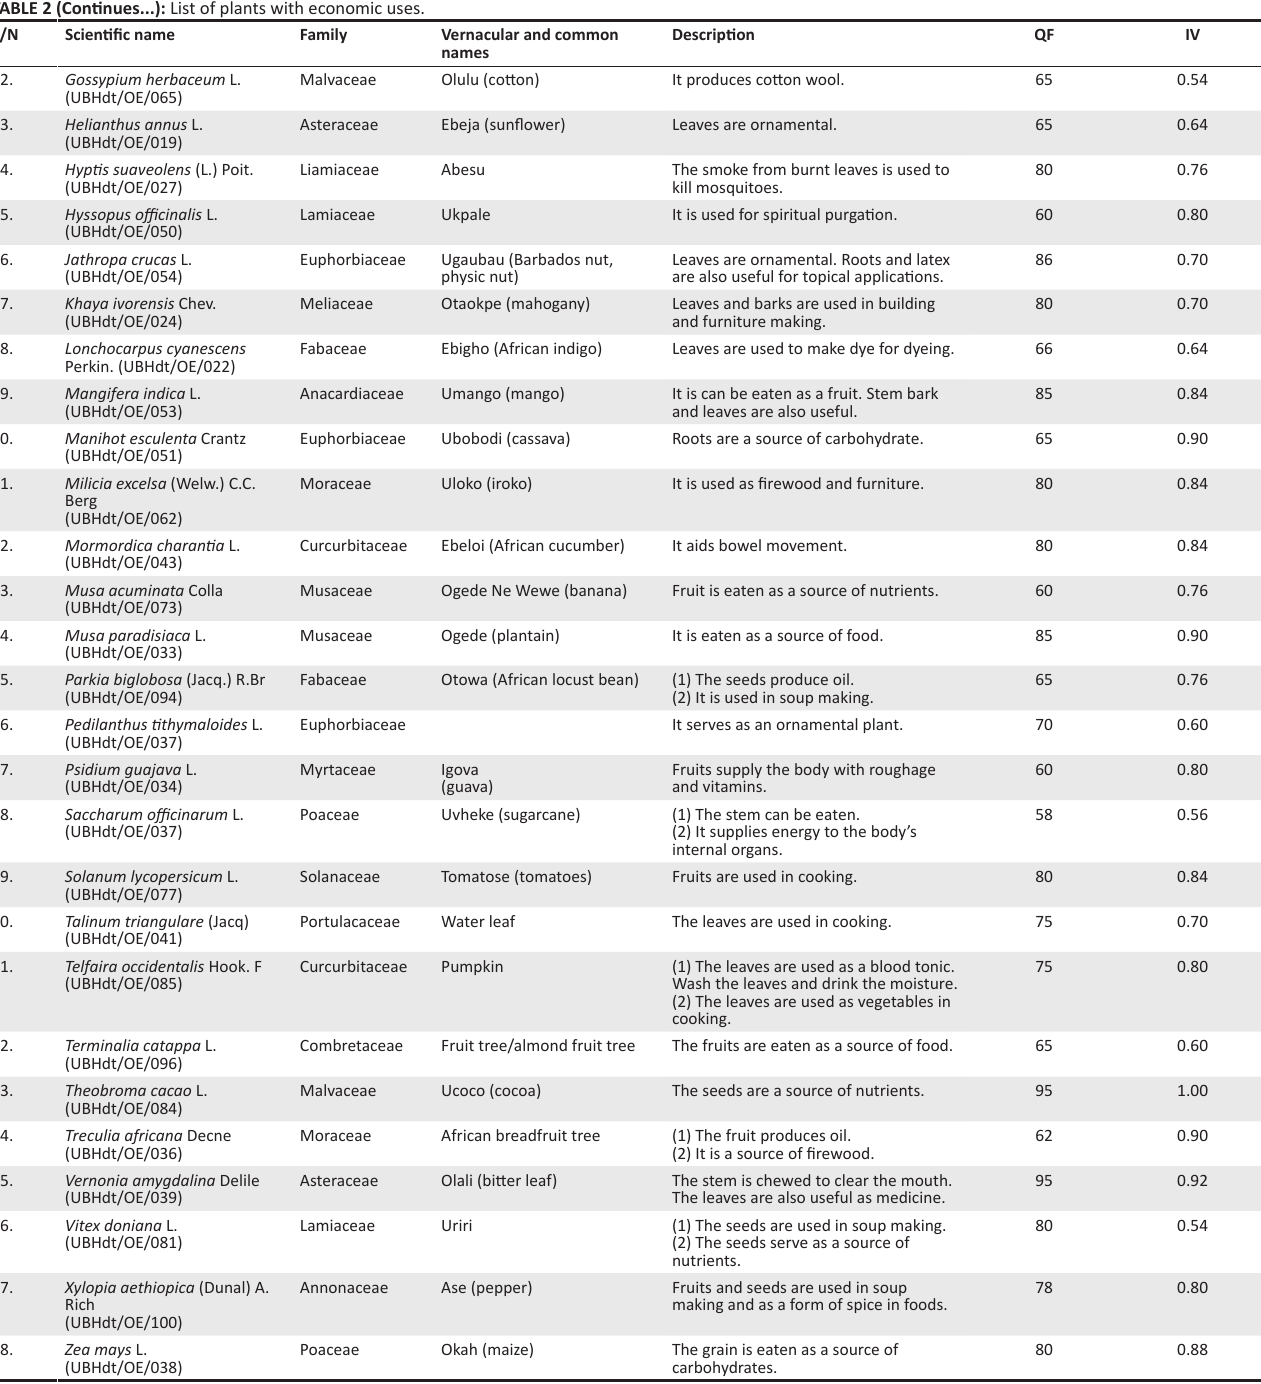
TABLE 2 (Continues...): List of plants with economic